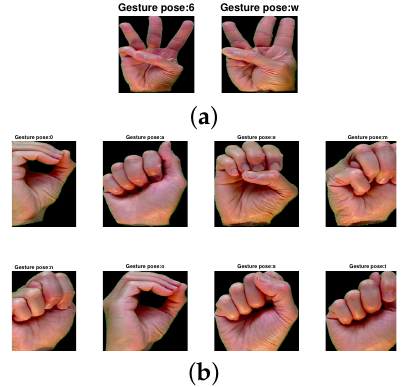
Figure 7. Similar gesture poses of MU dataset. ( a ) Most confused gesture poses of MU dataset ‘6’ and ‘w’. ( b ) Static ASL gesture poses with without any fingers held out are ‘0’, ‘a’, ‘e’, ‘m’, ‘n’, ‘o’, ‘s’ and